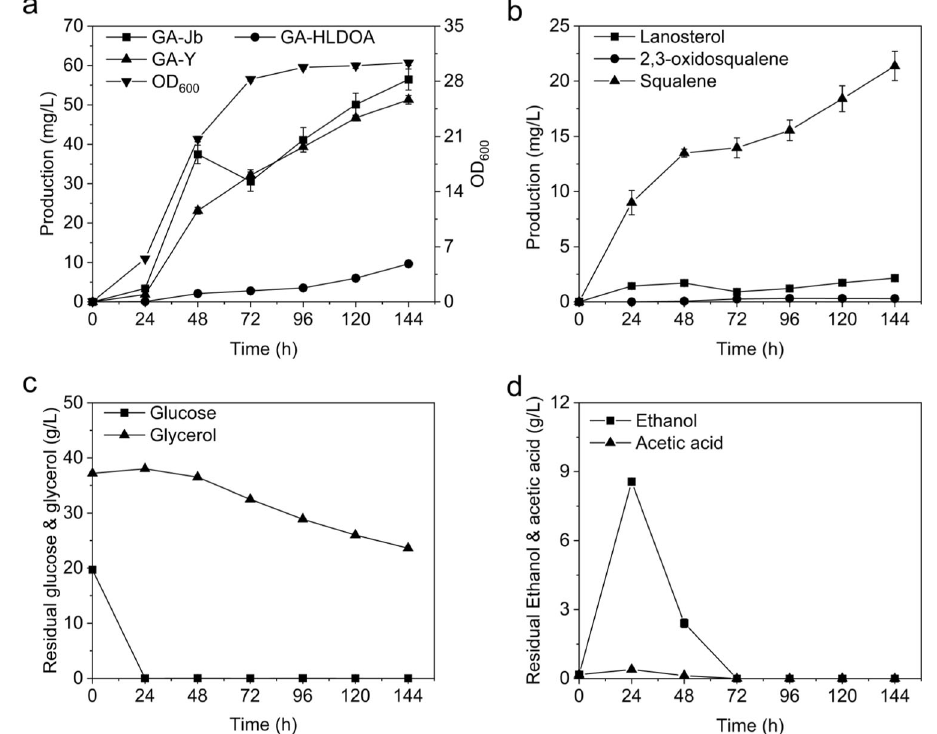
Fig. 6 | Fermentation behavior of strain CYP512W2-r-CYP5150L8-iGLCPR-r in a shake- fl ask system. Time pro fi les of a cell growth and 4 , 3 , and GA-HLDOA pro- duction; b theaccumulationoflanosterol,2,3-oxidosqualene,andsqualene; c residual